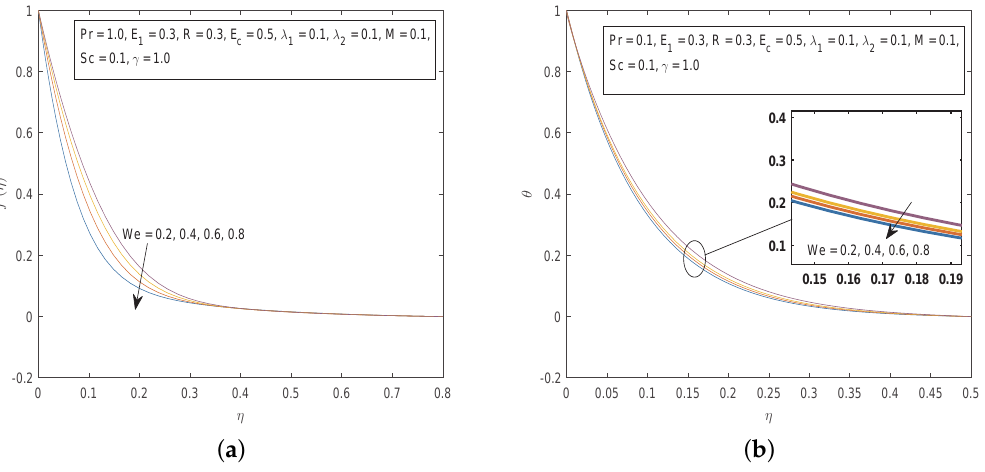
Figure 4. ( a ) Effects of We on f (cid:48) ( η ) and ( b ) Effects of We on θ